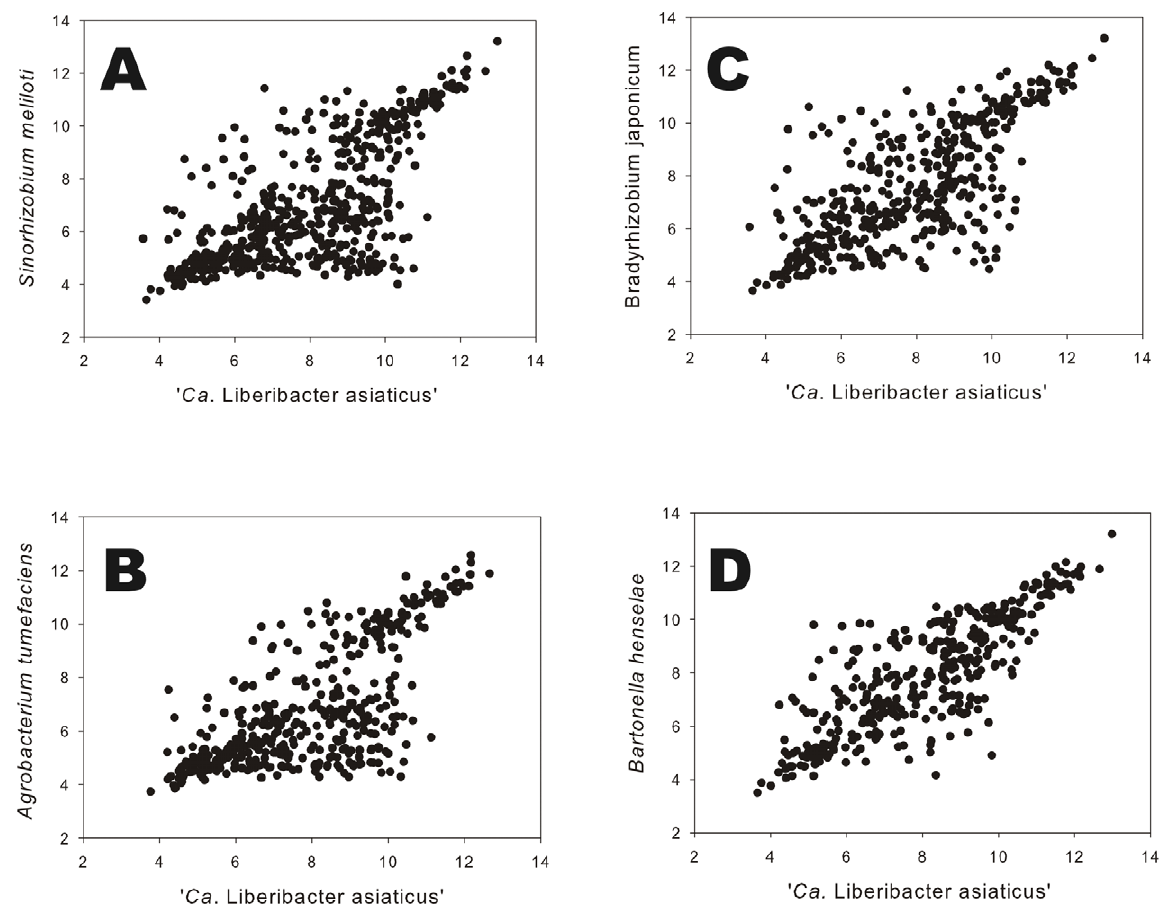
Figure 1. Isoelectric points of orthologous protein pairs. Orthologous proteins from ‘ Ca . Liberibacter asiaticus’ and Sinorhizobium meliloti (A), Agrobacterium tumefaciens (B), Bradyrhizobium japonicum (C) and Bartonella henselae (D).